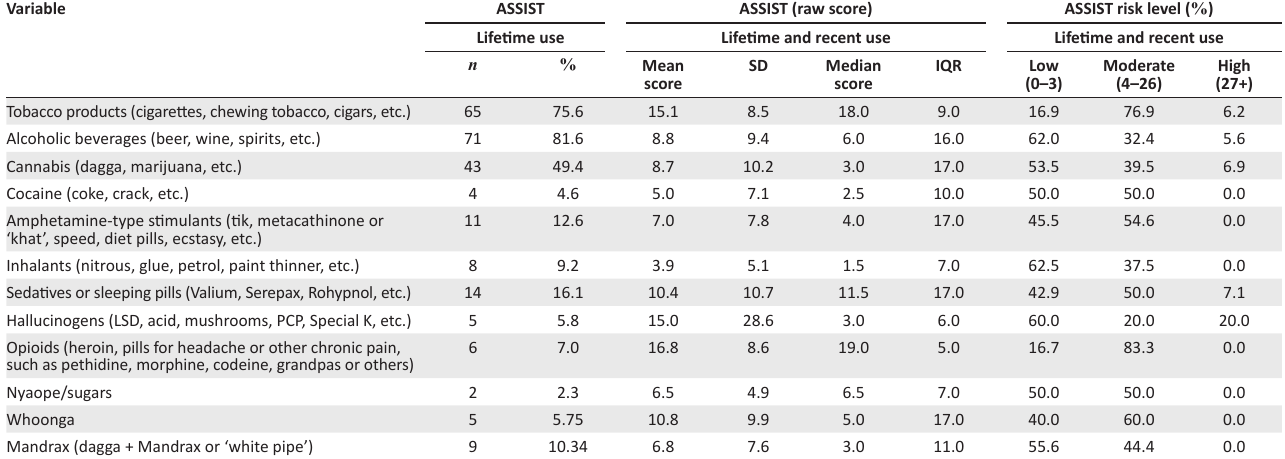
TABLE 2: Substance-use